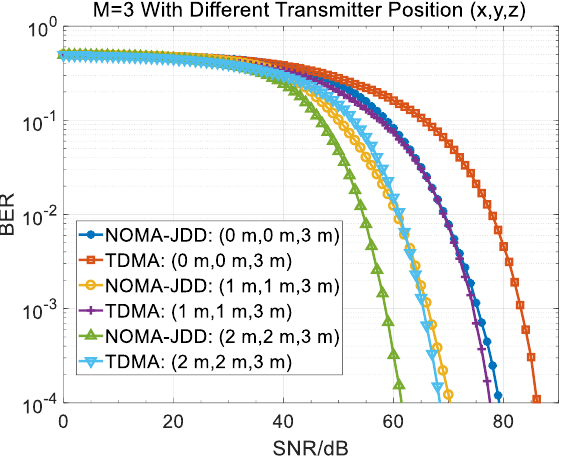
Figure 7. Three users’ average BER comparisons of our design and TDMA with K 1 = 1, K 2 = 2, K 3 = 1 for different transmitter